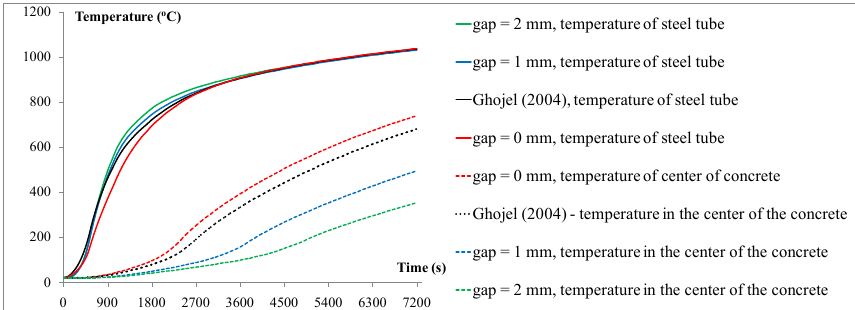
Figure 9. Temperature evolution according to the thickness of the air-gap